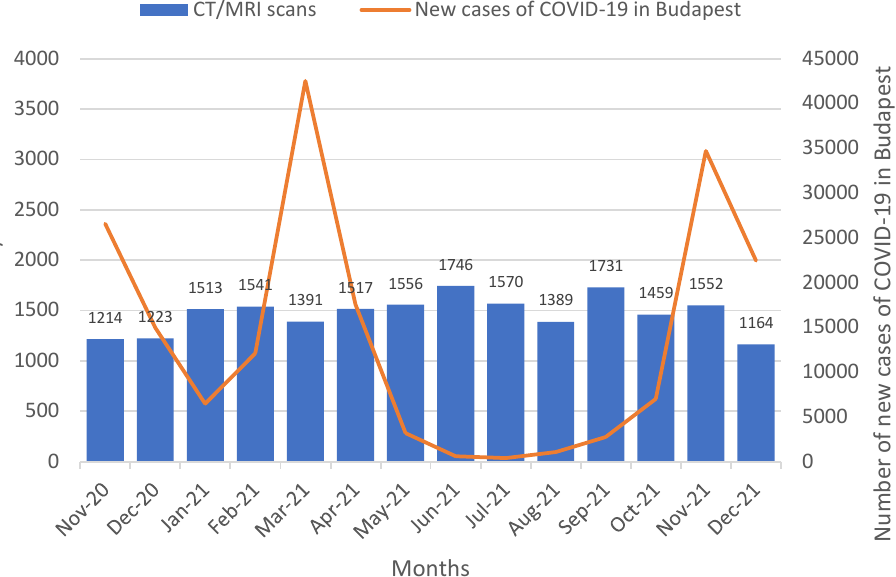
Figure 3. Monthly numbers of CT/MRI scans performed at Semmelweis University, Medical Imaging Centre during COVID-19 pandemic in Hungary from November 2020 to December 2021. Orange line: COVID-19 pandemic waves in Hungary.